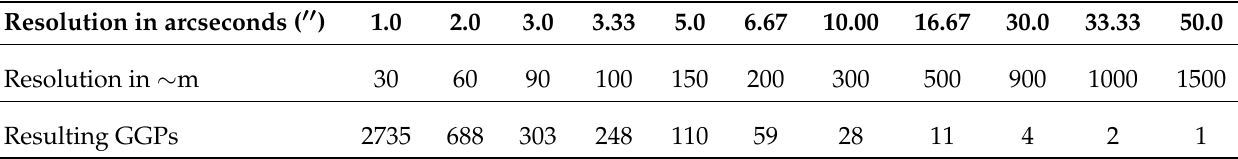
Table 3. Applied spatial resolutions and resulting glacier grid points (GGPs) for the Halji glacier. Not all applied resolutions are shown.